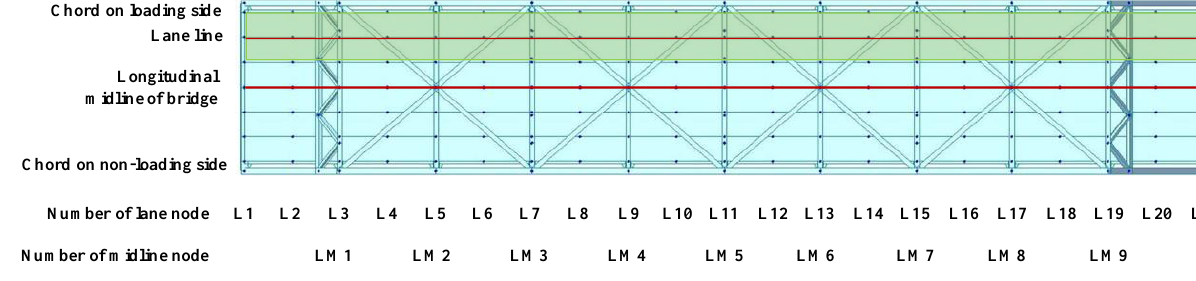
Figure 4. Diagram of loading position.